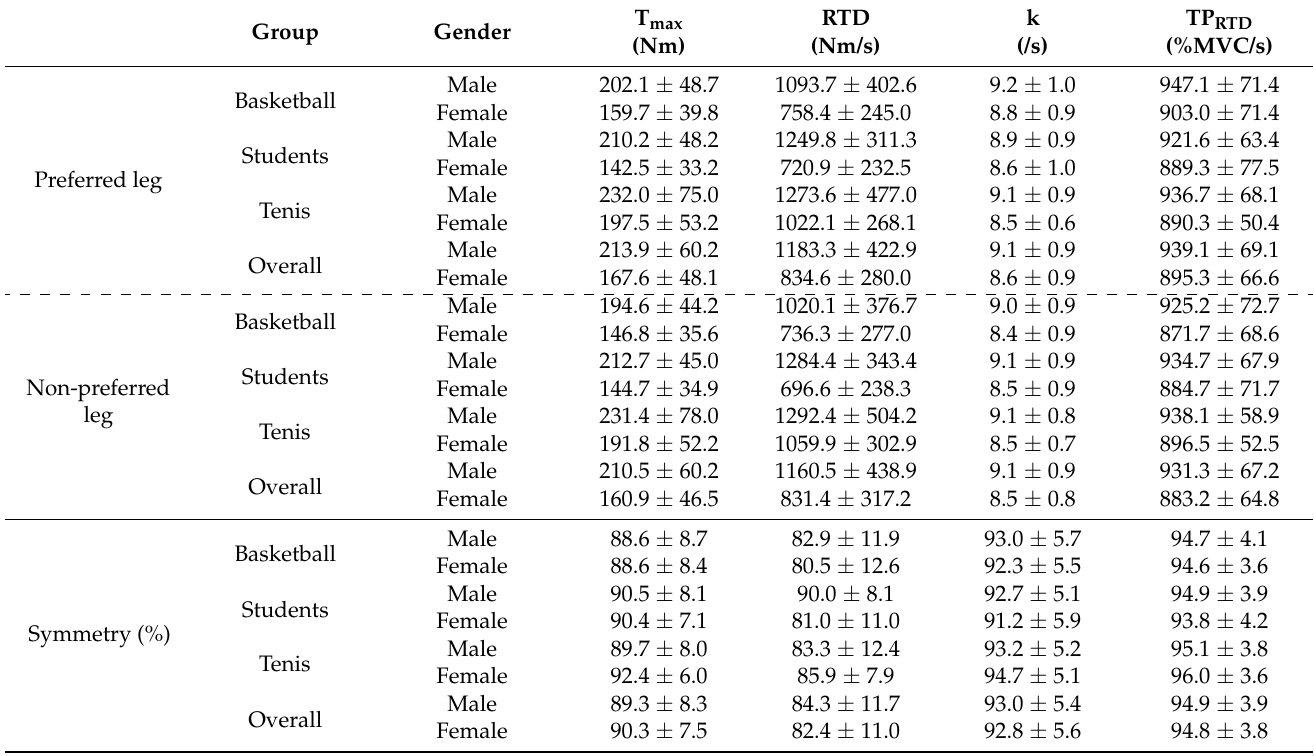
Table 2. Absolute and inter-limb symmetry values (mean ± SD) of knee extensors for different outcome measures.